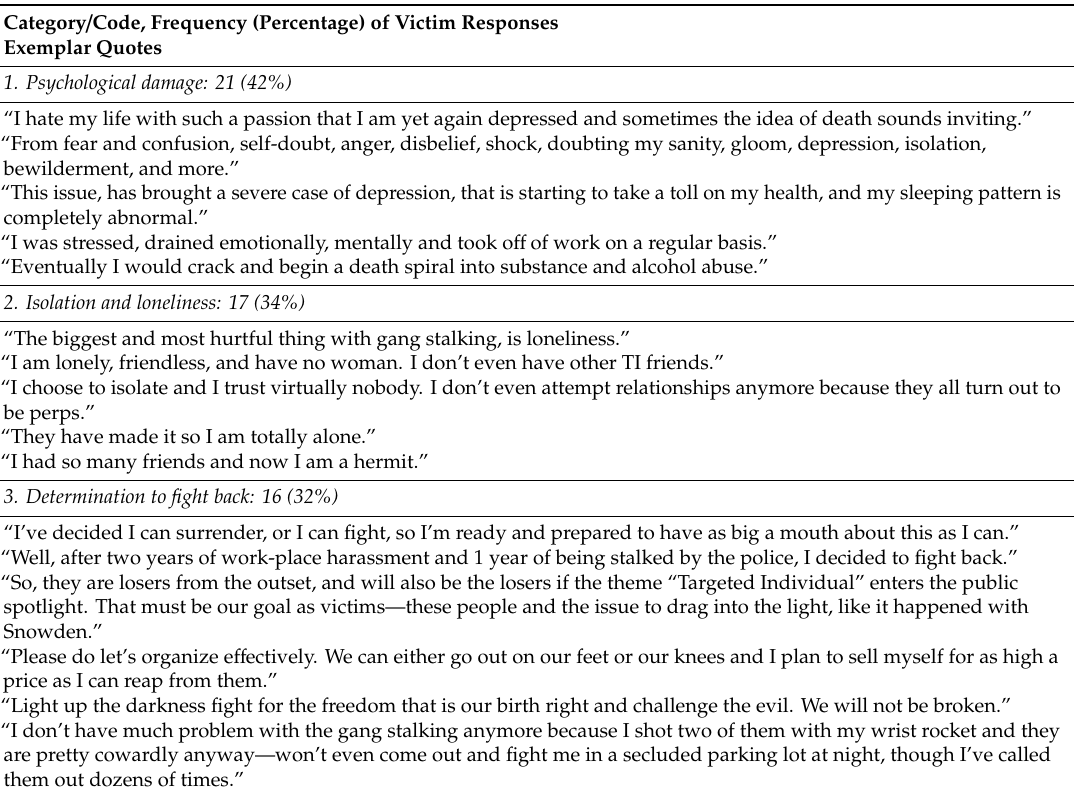
Table 2. Content analysis of self-defined gang stalking victims’ accounts of the sequelae of their